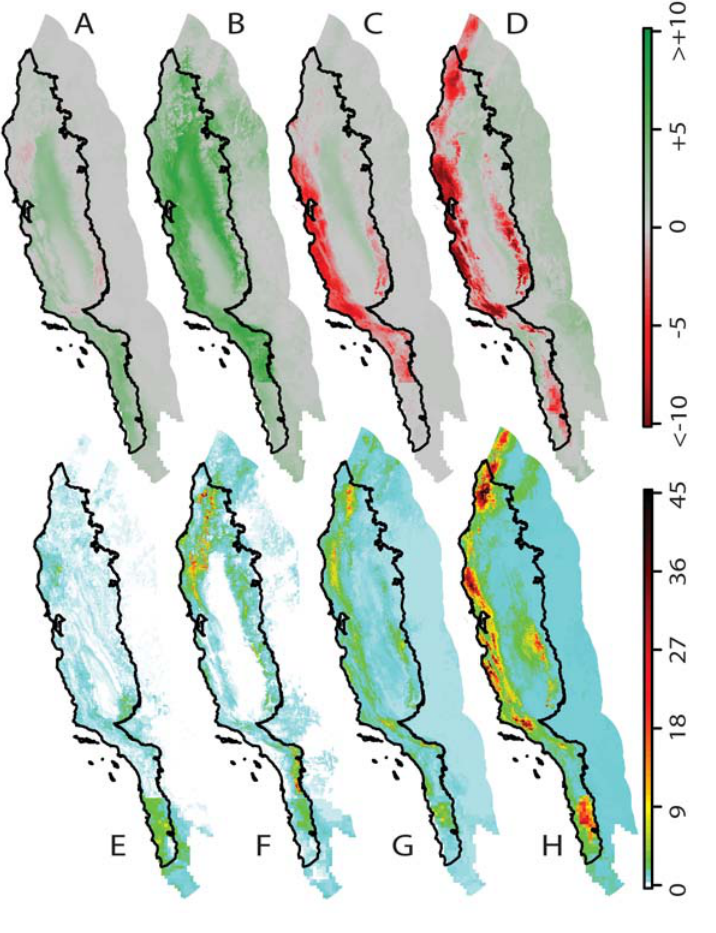
Figure 4. Future patterns of range size changes across increasing levels of climate change in which species can move. (A - D) Percent geometric mean change in range size (Future/Present with colors stretched from a , -10% decrease to a . 10% increase). (E - H) Diversity of species gains (future diversity with migration minus future diversity without migration) for the quarter species suffering the largest range contractions. (A, B, E, F) Simulations based on the lower-sensitivity PCM model. (C, D, G, H) Simulations based on the higher-sensitivity HadCM3 model. (A, C, E, G) Lower emissions (B1). (B, D, F, H) Higher emissions (A1FI).